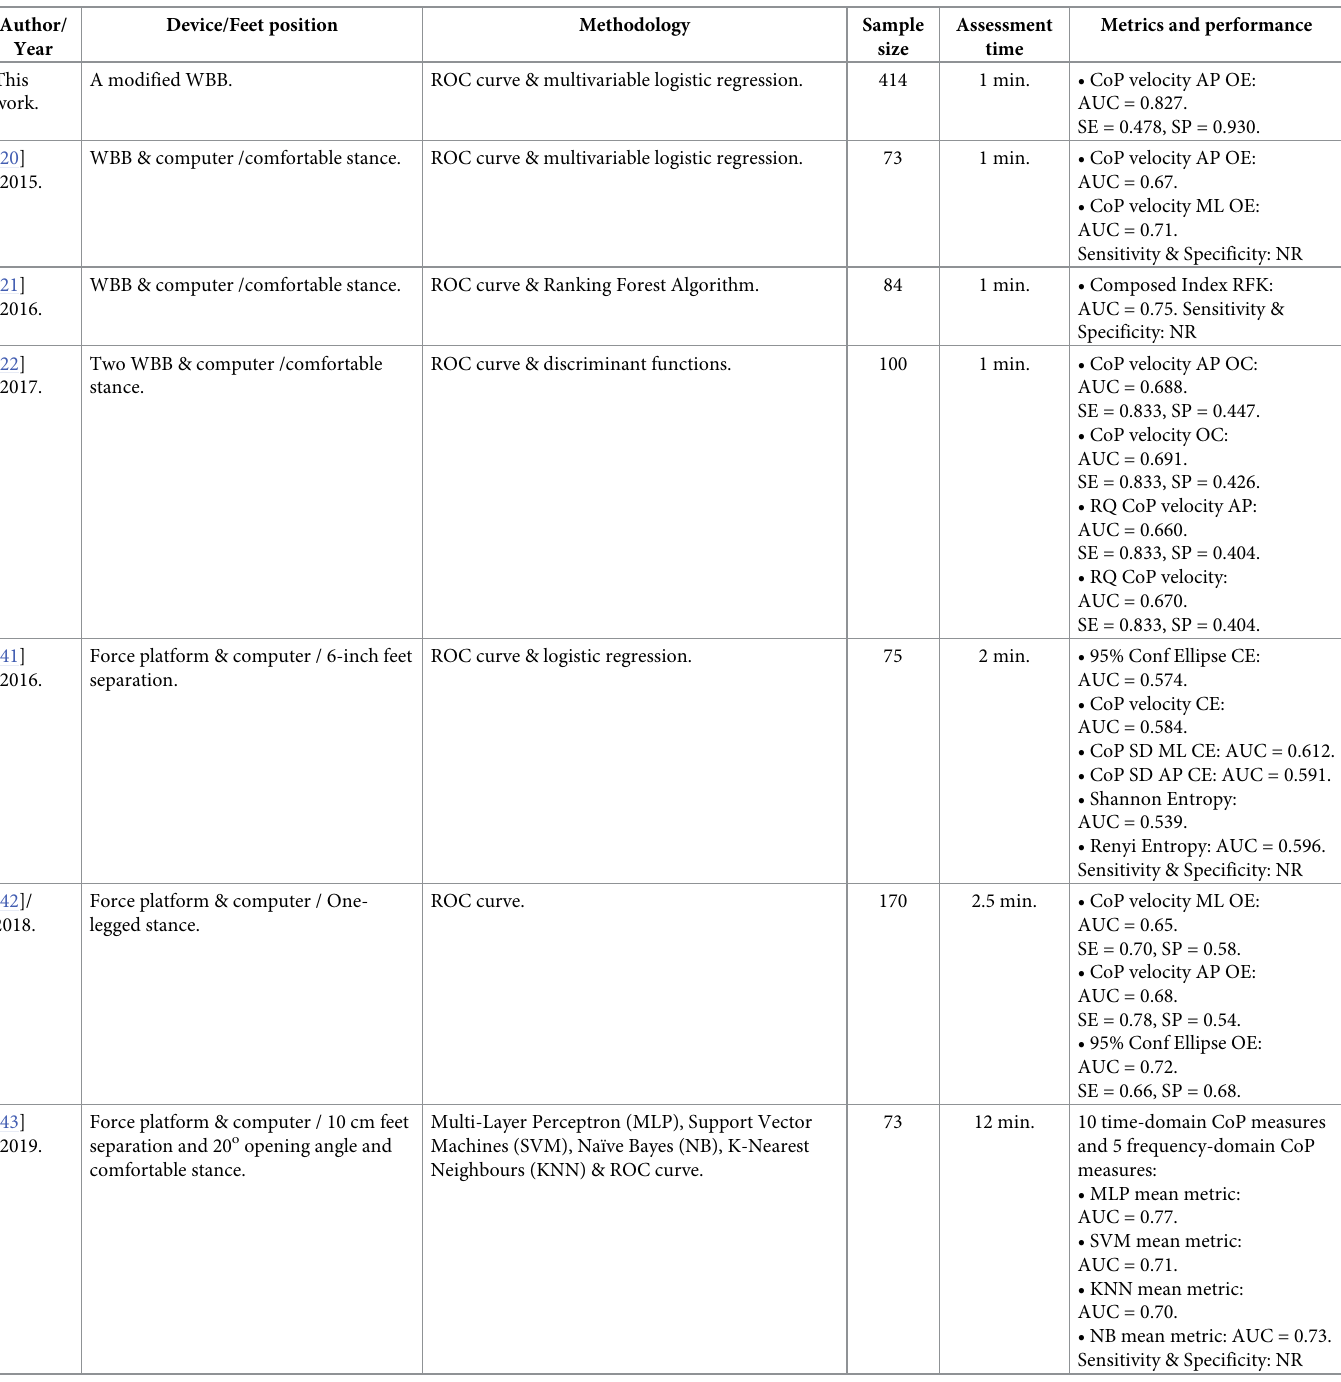
Table 4. Some works about fall risk estimation, fall prediction, balance impairment, and fall identification in older